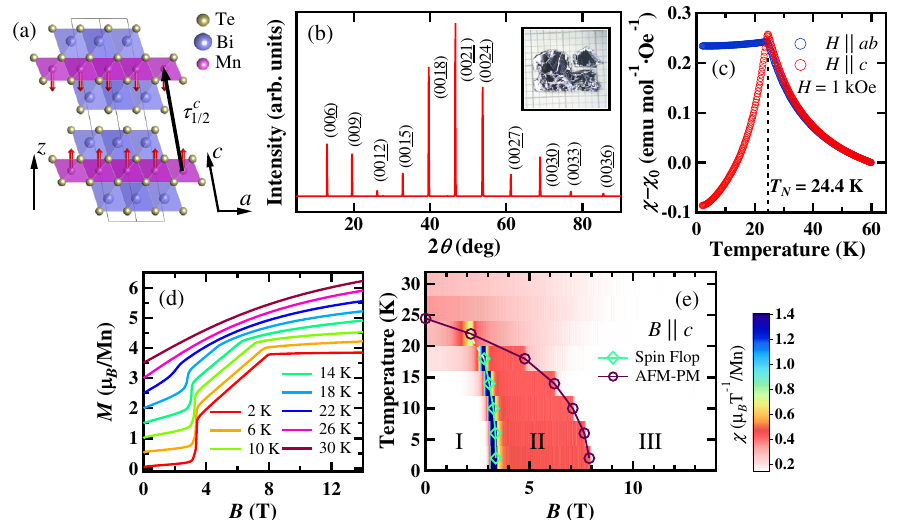
FIG. 1. Crystal characterization and magnetic responses of MnBi 2 Te 4 . (a) Crystal structure and A -type AFM magnetic configuration. (b) Single crystal x-ray diffraction data. Inset: Crystal against a millimeter grid. (c) Magnetization curves in two different configurations, H k ab and H k c . The susceptibility at 60 K ( χ 0 ) is subtracted. (d) Field dependence of magnetization M , measured at different T , with field along the c axis. (e) The field-temperature phase diagram with applied field along the c axis. As B increases, the system evolves from an A -type AFM state (I) to a spin-flop AFM state (II), then to a high- T PM state